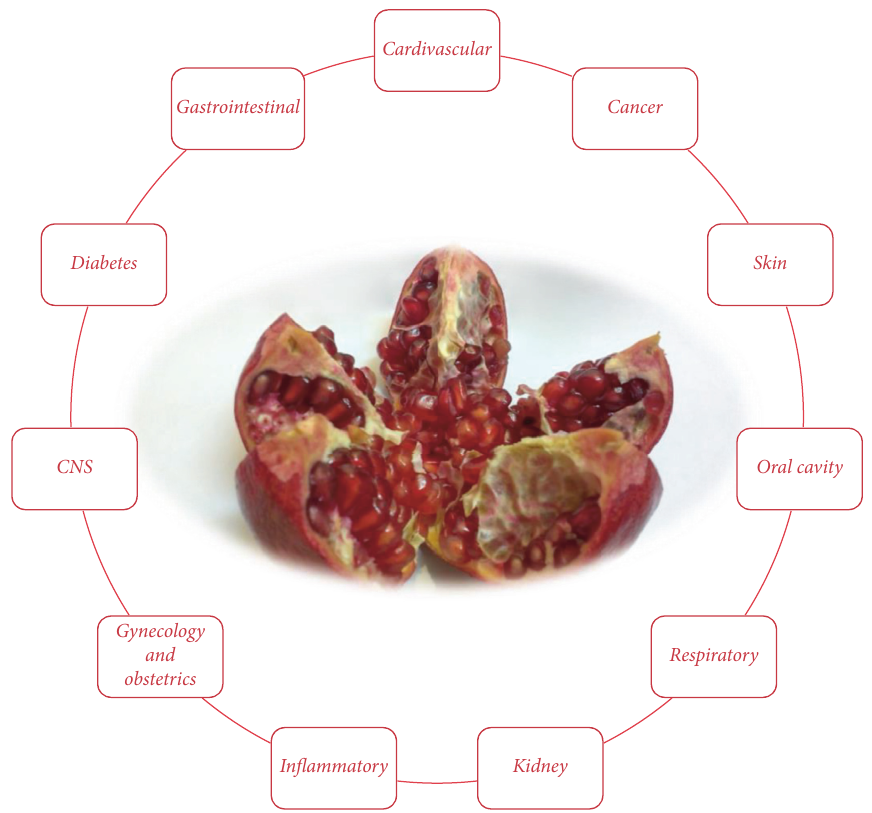
Figure 4: A summary of pomegranate clinical trials in different